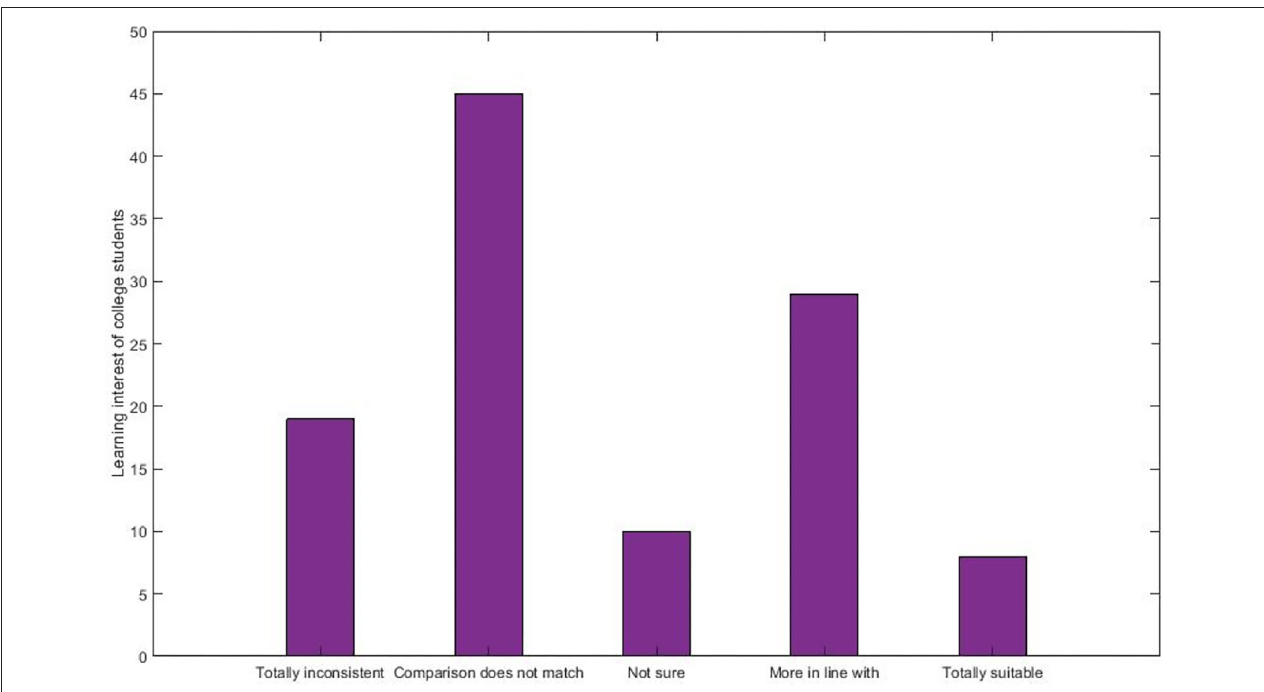
FIGURE 11 | Learning interest.